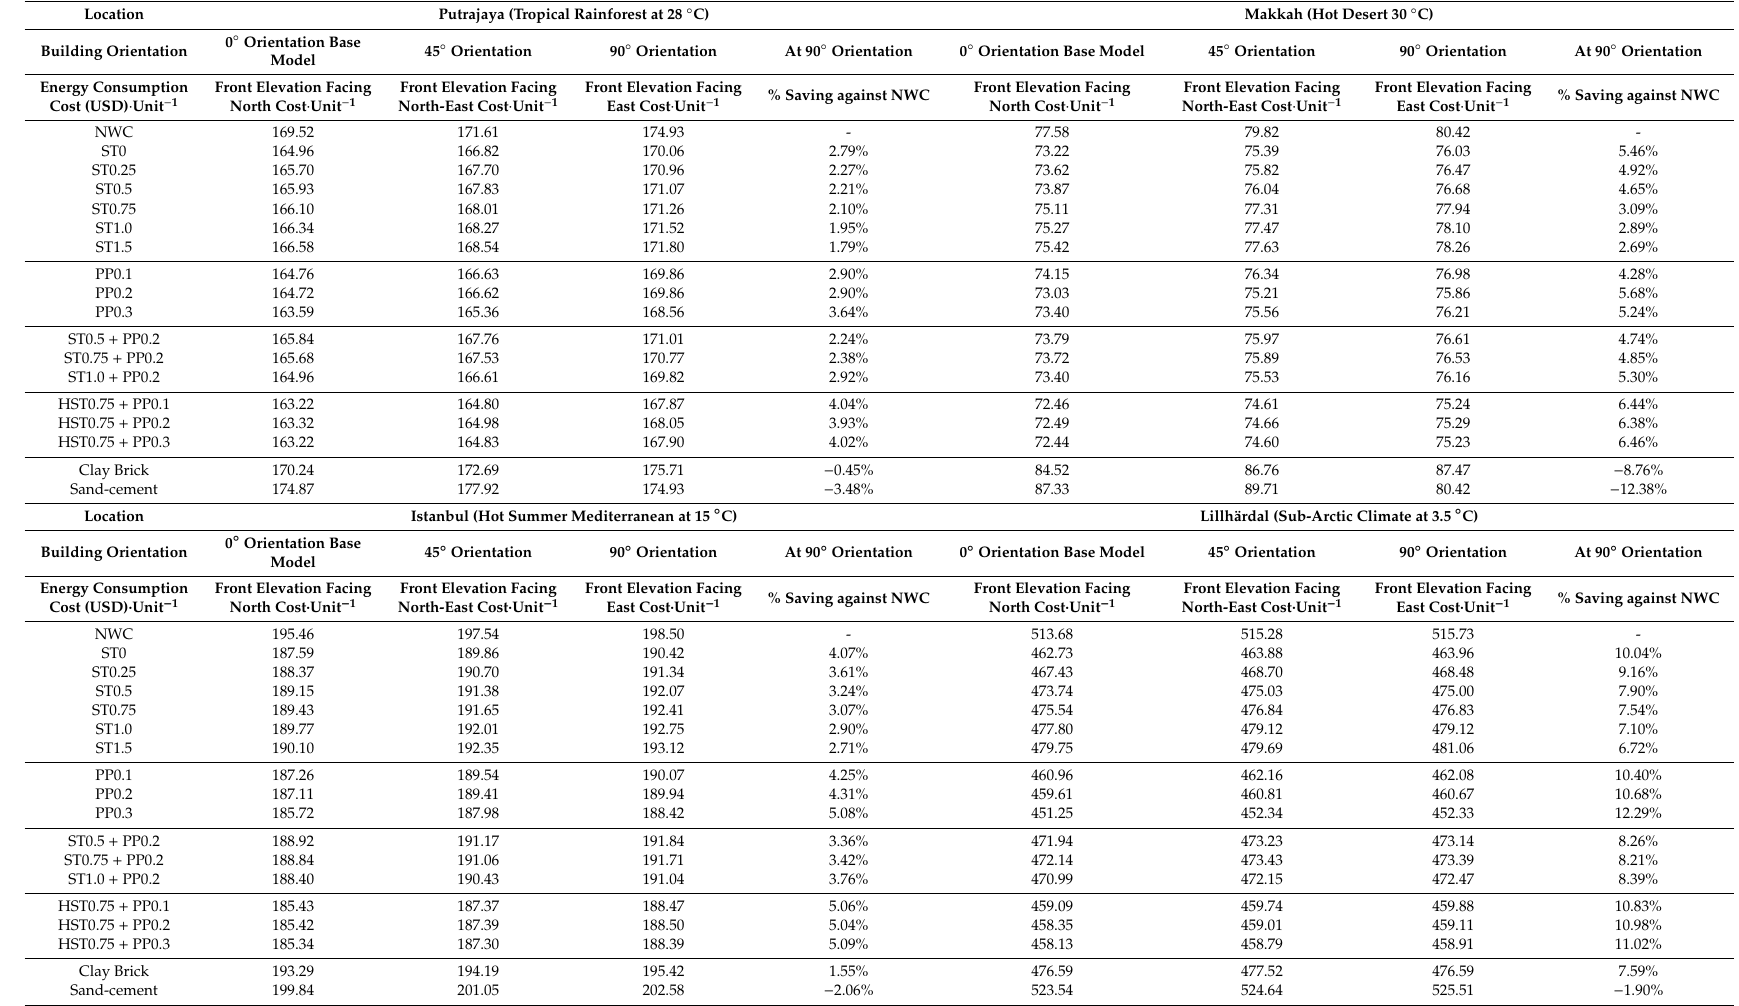
Table 7. Energy cost (USD) per month / unit and its savings as compared to NWC associated with its orientation at di ff erent climatic regions, continued. Location